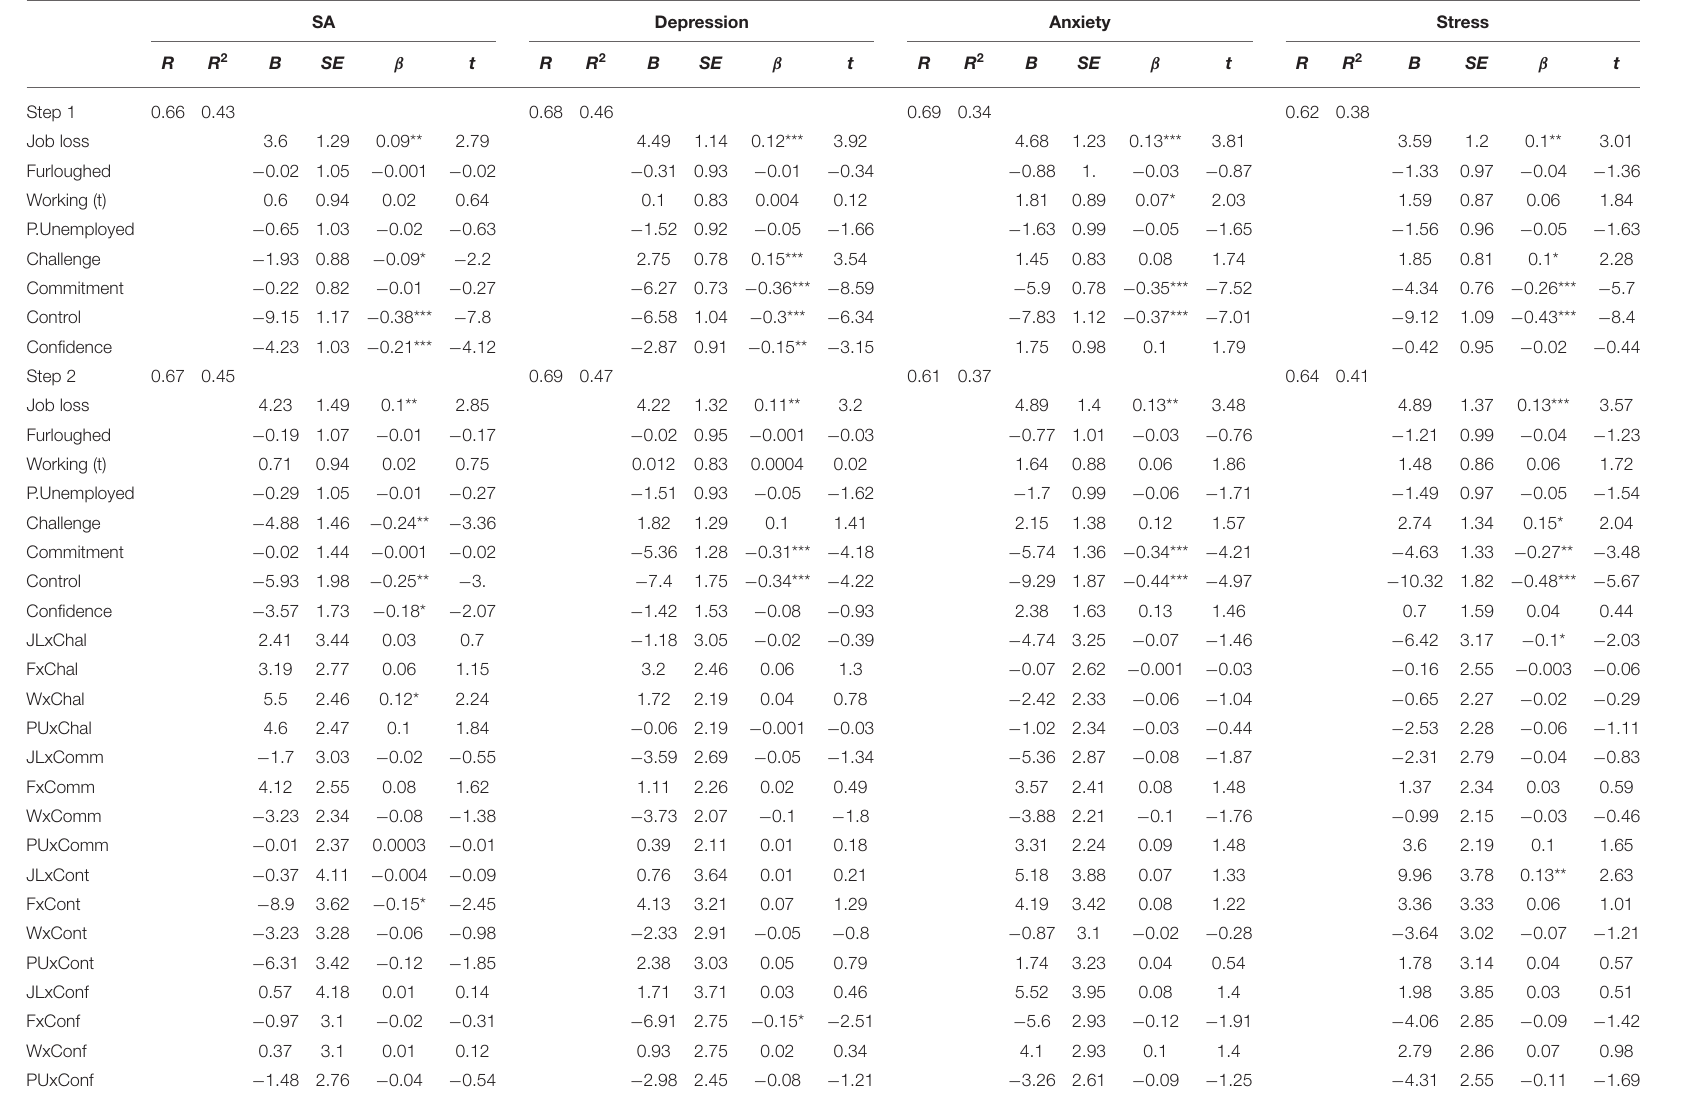
TABLE 8 | Hierarchical multiple regressions for emotional states. SA Depression Anxiety